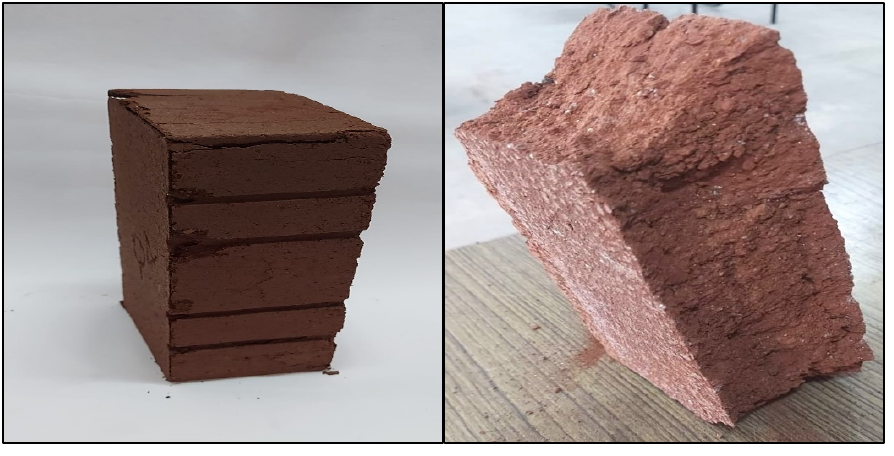
Figure 16. Failure of SRMB after compressive strength.